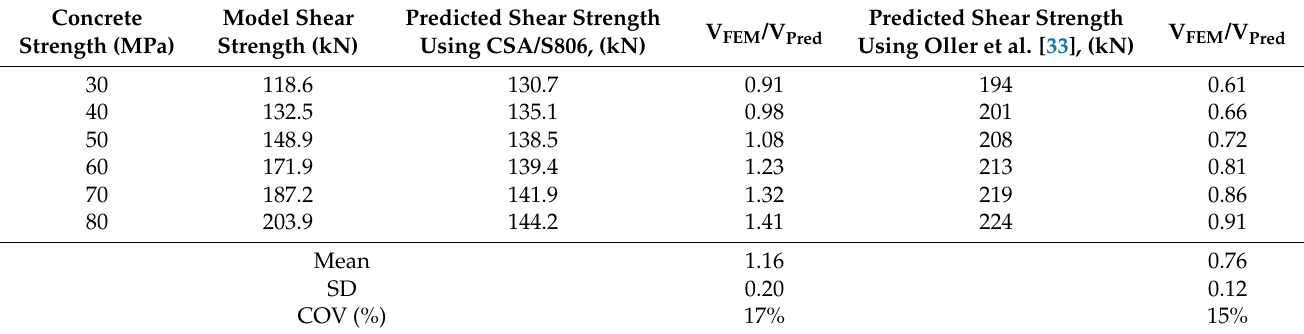
Table 4. FEM results and predicted shear strength for beam specimens with variable compressive strength.